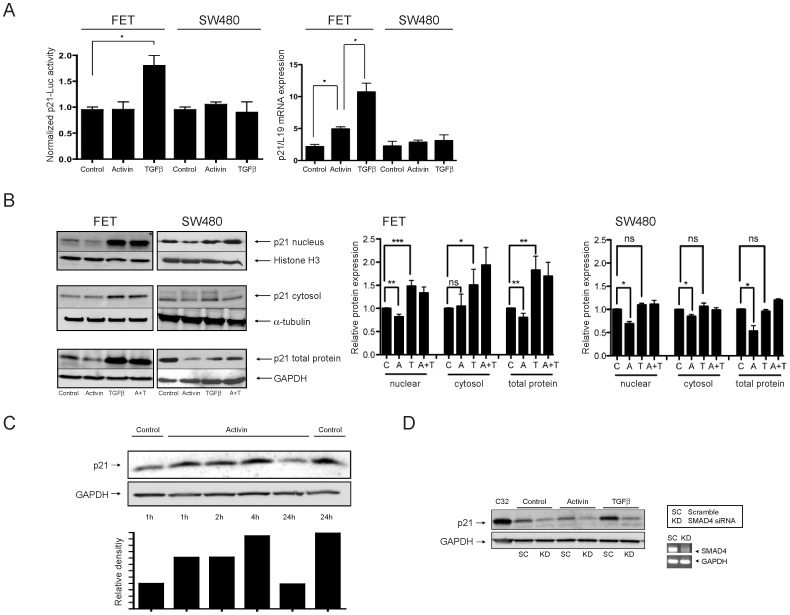
While TGFβ increases p21 expression in the presence of SMAD4, activin decreases nuclear and total p21 independent of SMAD4 status.A) SMAD4-wild type FET and SMAD4-null SW480 colon cancer cells were treated with vehicle (control), activin, or TGFβ for 24 hours. p21-specific transactivation was determined using a dual luciferase assay with pWWP-luc and pRL-TK (left panel) and mRNA expression levels of p21 were quantified by qPCR and normalized to L19 (right panel). While TGFβ markedly induced both p21-specific transactivation and transcription in the presence of SMAD4, no increase in p21 transactivation and only a modest increase in transcription following activin treatment in the presence of SMAD4 were found (*p<0.05). B) SMAD4-wild type FET and SMAD4-null SW480 cells were treated with control vehicle (C), activin (A), TGFβ(T), or a combination of both ligands (A+T) for 24 hours prior to lysis for total protein, nuclear, and cytoplasmic preparation. Histone H3, α-tubulin, and GAPDH were used as loading controls for the respective fractions. While TGFβ markedly increased p21 levels in all three fractions in the SMAD4 positive cell line only, activin induced a decrease in nuclear and total p21 protein in SMAD4-positive and -negative cells (left panel). Densitometric analysis of all blots revealed statistically significant changes in p21 levels (right panel) (ns  =  non-significant, *p<0.05, **p<0.01, ***p<0.001). C) Initial upregulation of p21 protein is followed by downregulation by 24 h after activin treatment. SMAD4-wild type FET cells were treated with activin or vehicle (control) and harvested at various time points for quantification of p21 protein expression. GAPDH was used as loading control and relative expression was calculated via densitometry. D) While TGFβ-induced upregulation of p21 was SMAD4 dependent, activin-induced downregulation of p21 was still observed in the absence of SMAD4. SMAD4-wild type FET cells were treated with vehicle (CNT), activin or TGFβ in the presence of either scramble siRNA (SC) or SMAD4 siRNA (KD) and total p21 levels were determined. GAPDH was used as loading and C32 cell lysate as p21 positive control.